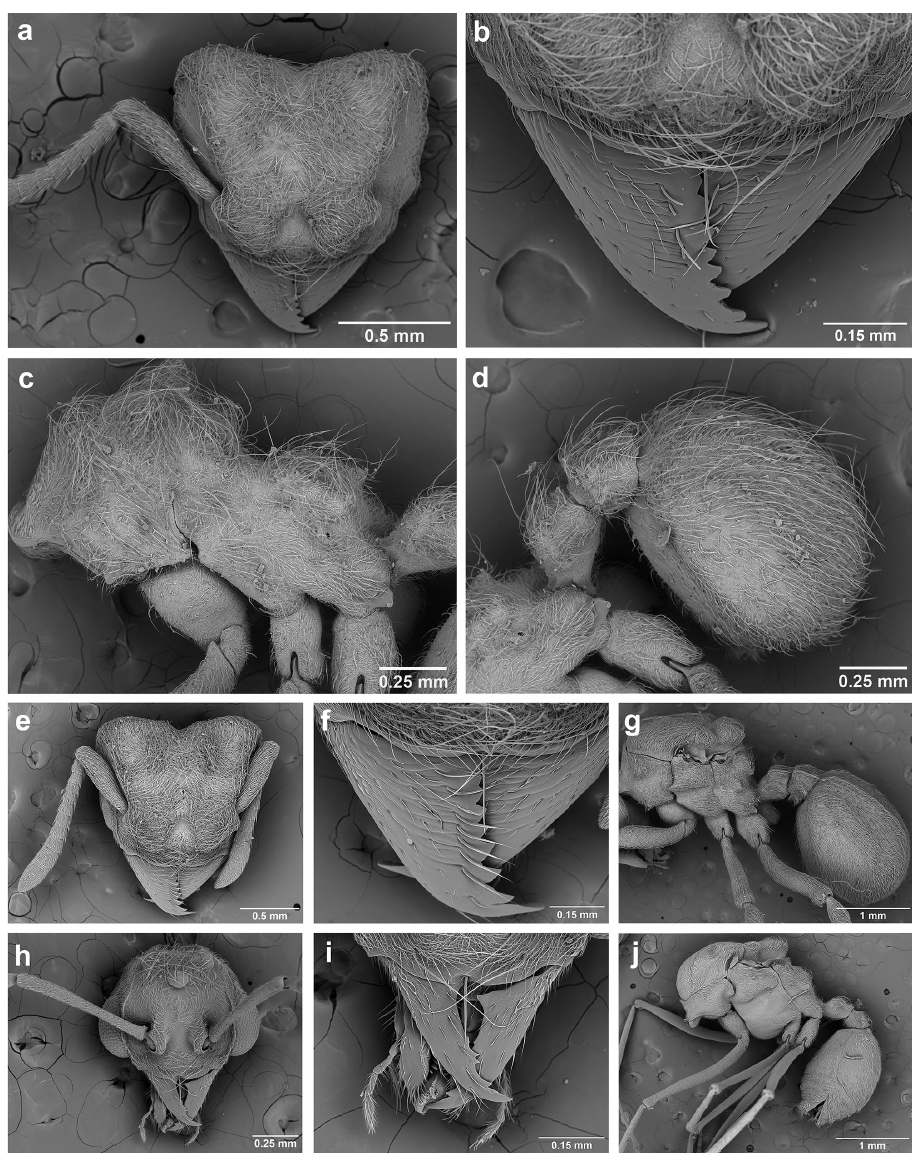
Figure 18. S. amabilis worker, queen, and male, SEM images. Worker (USNMENT01125862): a head, full-face view b mandibles c mesosoma, lateral view d metasoma, lateral view. Queen (USN- MENT01125864): e head, full-face view f mandibles g mesosoma and metasoma, lateral view. Male (USNMENT01125863): h head, full-face view i mandibles j mesosoma and metasoma, lateral